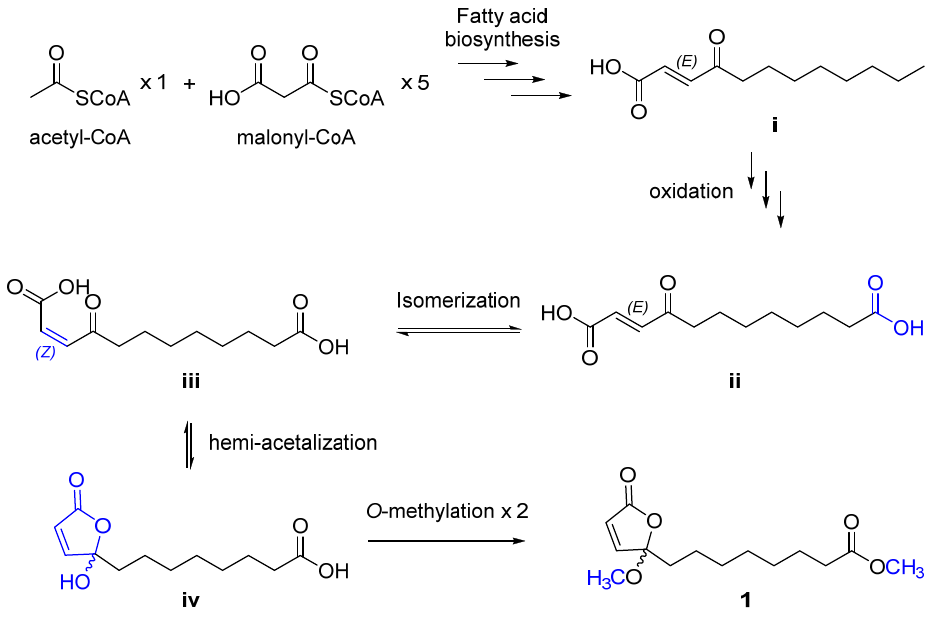
Figure 3. Plausible biosynthetic pathway of 1